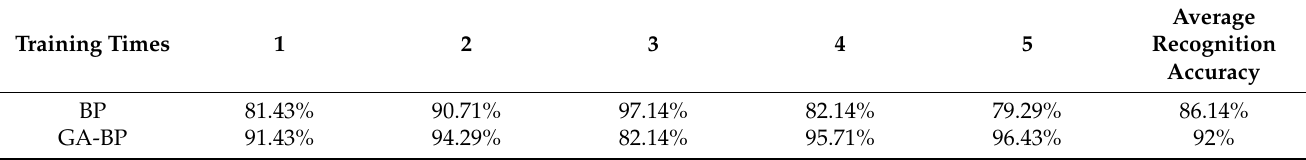
Figure 10. The results of motor fault pattern recognition. ( a ) Classification results; ( b ) classification error. Table 4. Accuracy of motor pattern recognition.